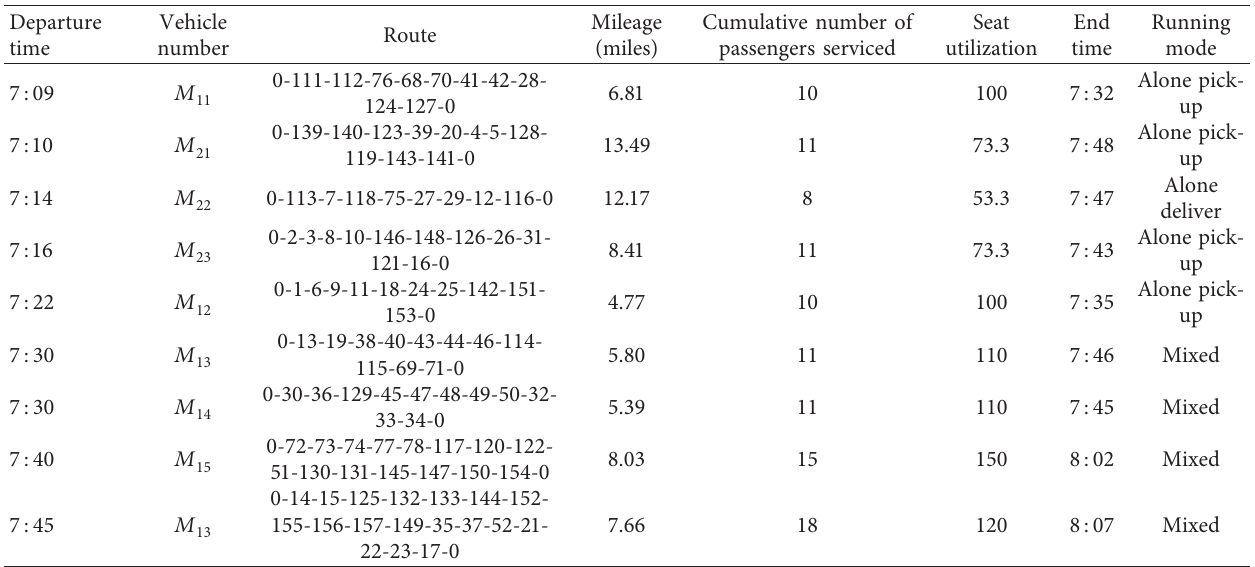
Table 10: Optimization results under mixed running in the optimal service area.